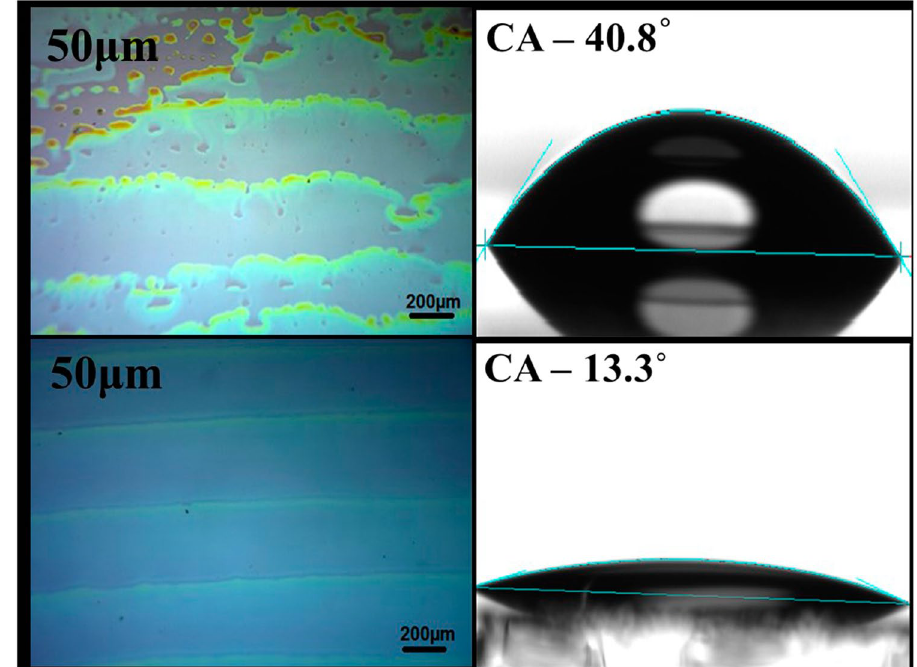
Figure 1. Left: Optical micrographs of printed NiO films printed at a drop spacing ~50 μ m, Right: Contact angle measurement images on ITO/Glass substrates with and without UV-Ozone treatment.